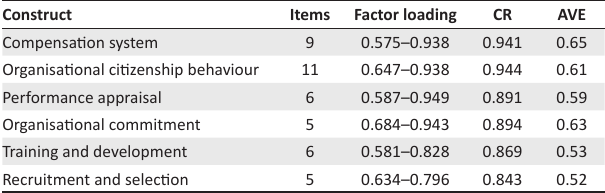
TABLE 3: Confirmatory factor analysis result. Construct